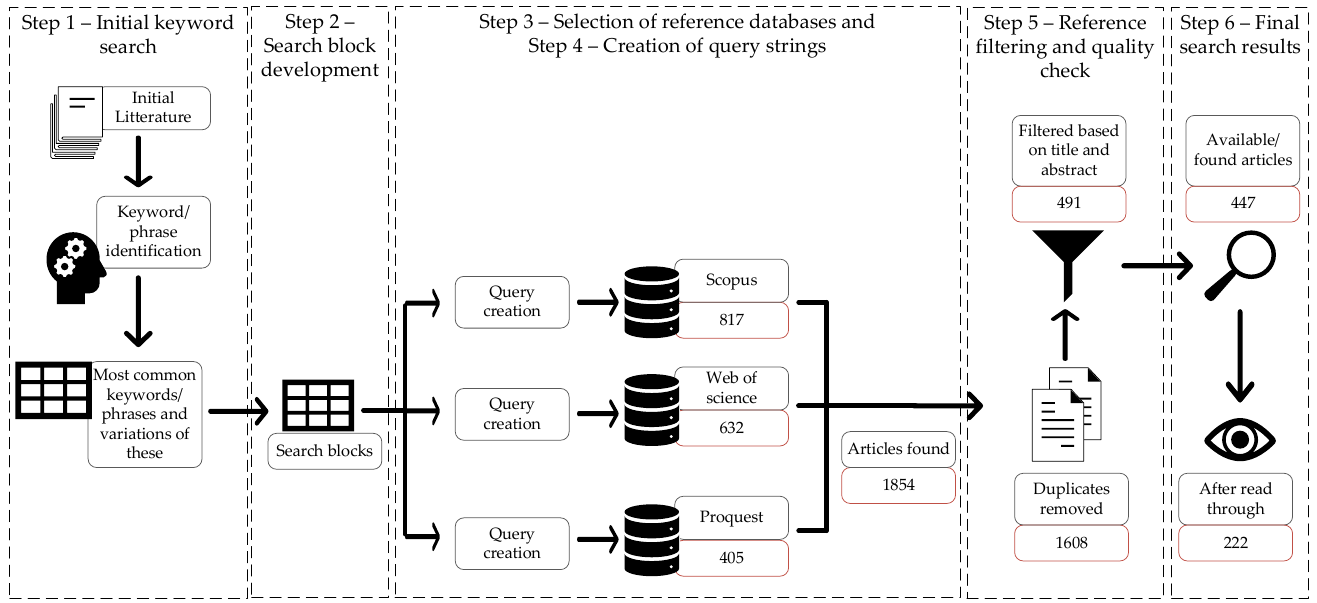
Figure 1. Flowchart of literature search methodology. The black boxes identify the action, and the red boxes quantify the number of relevant articles remaining after the corresponding action was